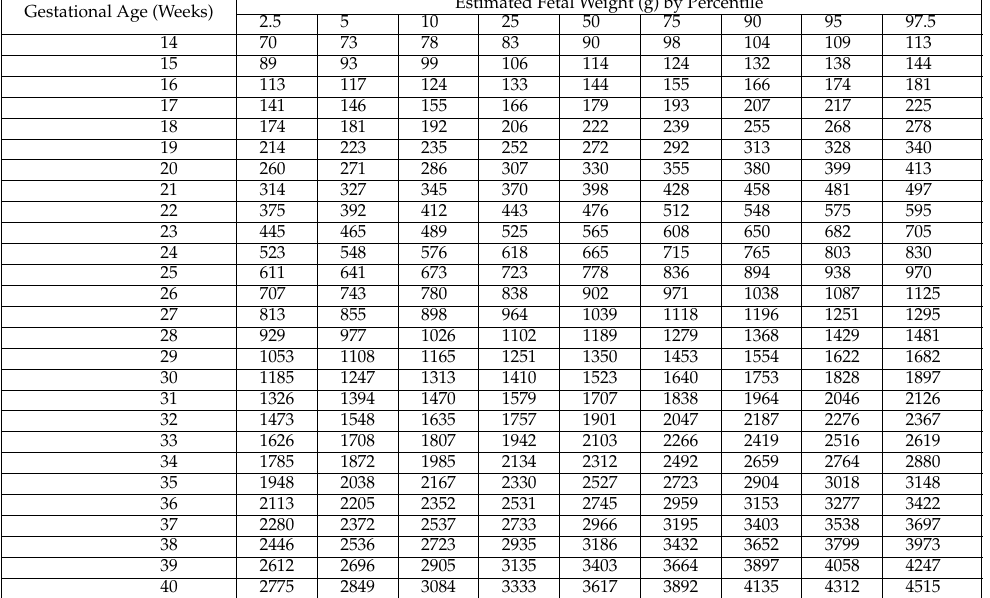
Table A1. Growth chart for estimated fetal weight regardless of fetal